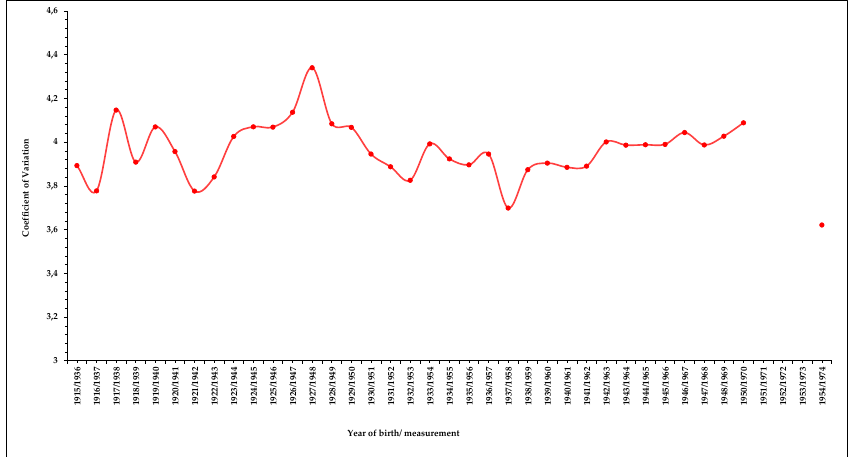
Figure 3. Secular trend in coe ffi cient of variation (CV), all districts considered (Source: AGMG).